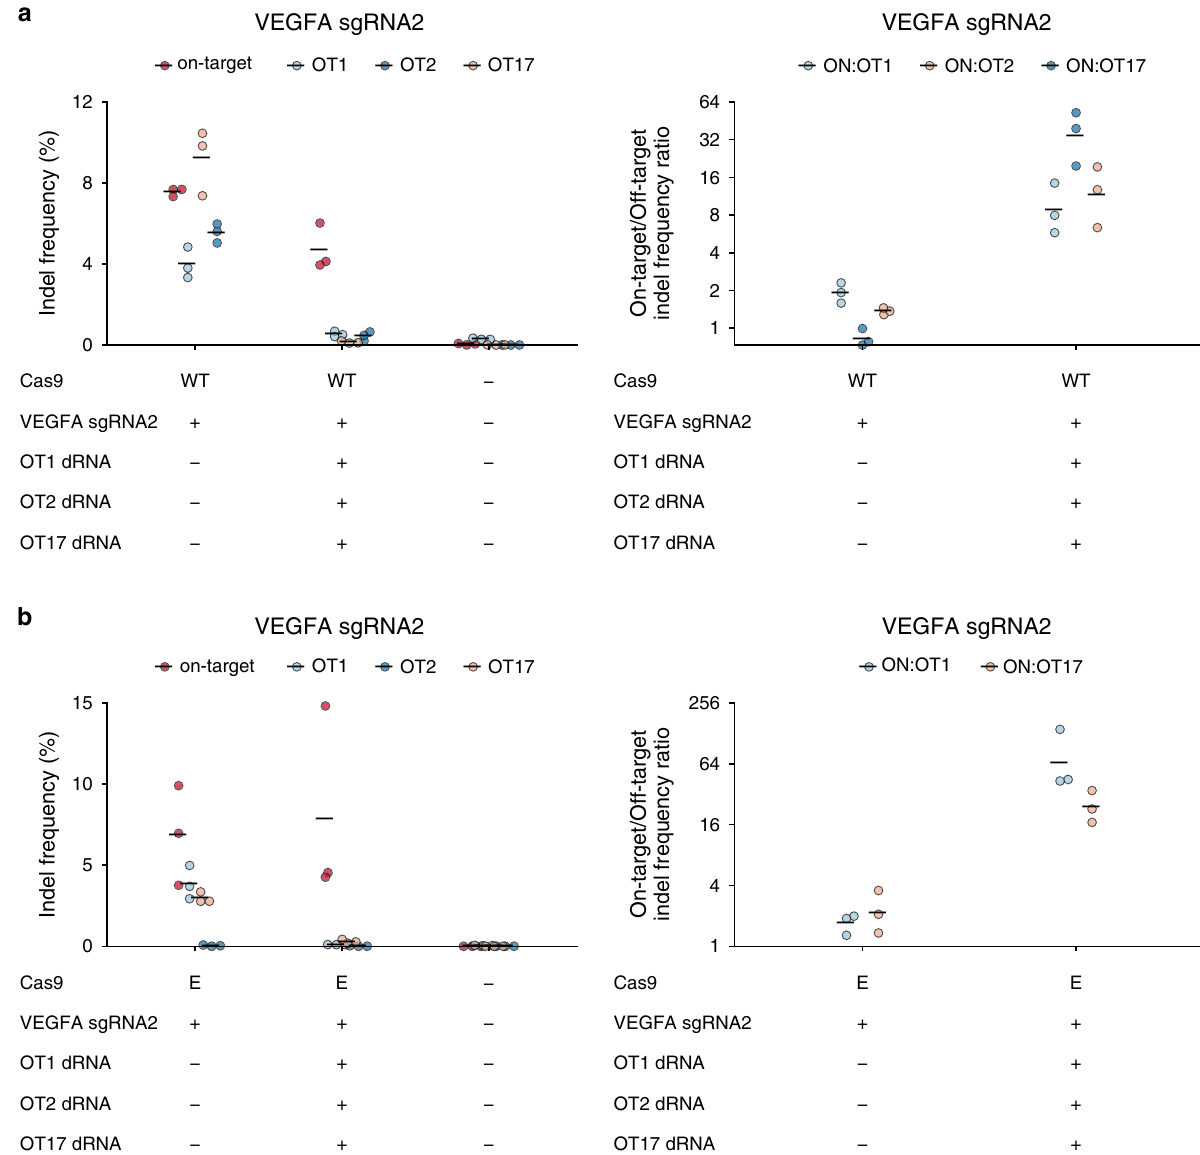
Fig. 5 dRNAs can be multiplexed to suppress several off-targets simultaneously. Indel frequencies and speci fi city ratios 24 h after transfection of plasmids encoding either a wild-type (WT) or b eSpCas9 (E), VEGFA sgRNA2, and dRNAs targeting one of three VEGFA sgRNA2 off-targets (OT1 dRNA1, OT2 dRNA8, OT17 dRNA8). Means of n = 3 cell culture replicates depicted by solid lines. OT off-target. Source data are available in the Source Data fi